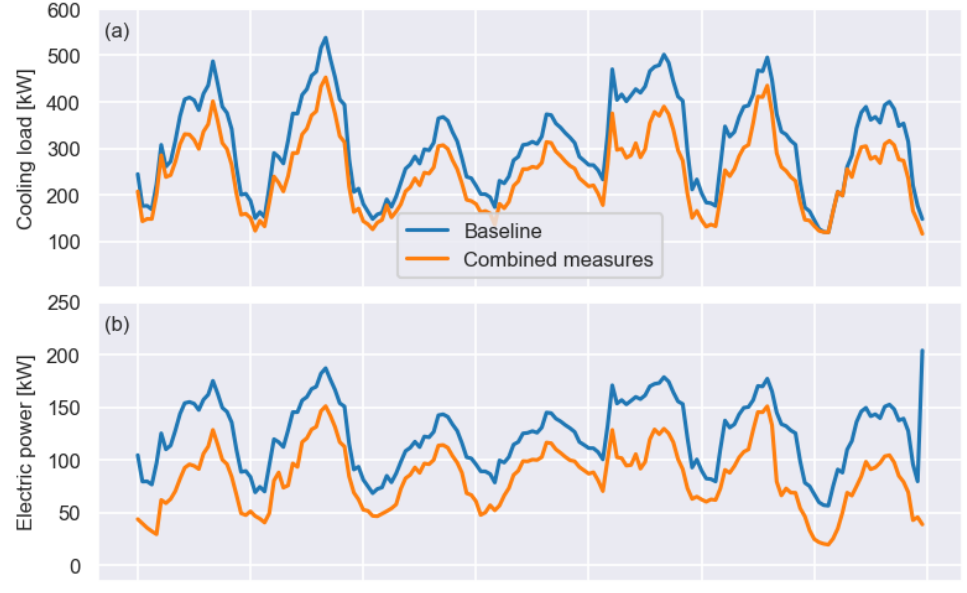
Figure 17. ( a ) Building cooling load; ( b ) electric power for the baseline and the combined measures for a typical week. The electric power is the contribution of the chilled water system power and the increased fan power, as given in Equation (12). increased fan power, as given in Equation (12).